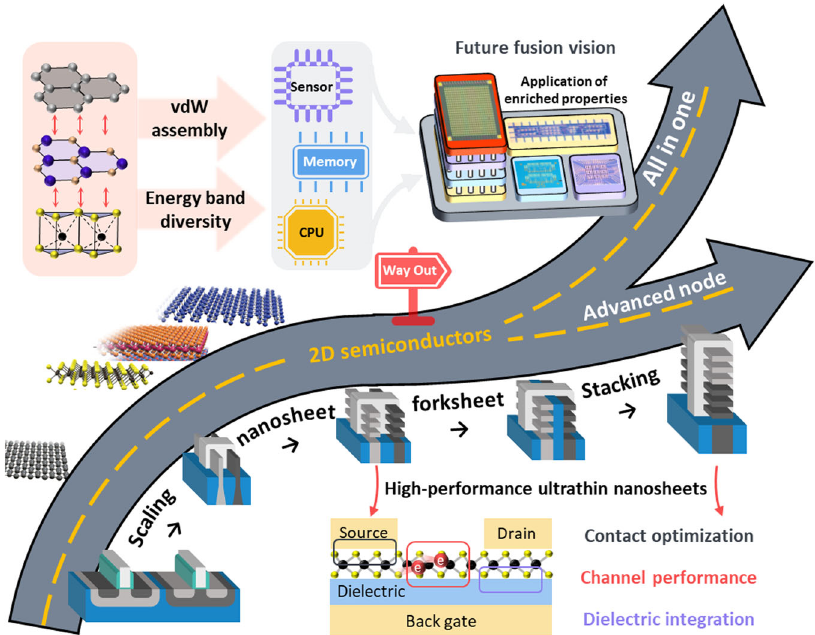
Fig. 1 A schematic diagram of the potential road of speci fi c electrical applications for 2D semiconductors. The bottom panel shows a route for 2D semiconductors to serve as ultrathin high-performance nanosheets in the future transistor architecture. The top panel shows the novel properties of 2D materials and opportunities for speci fi c applications from functions to integrated systems.